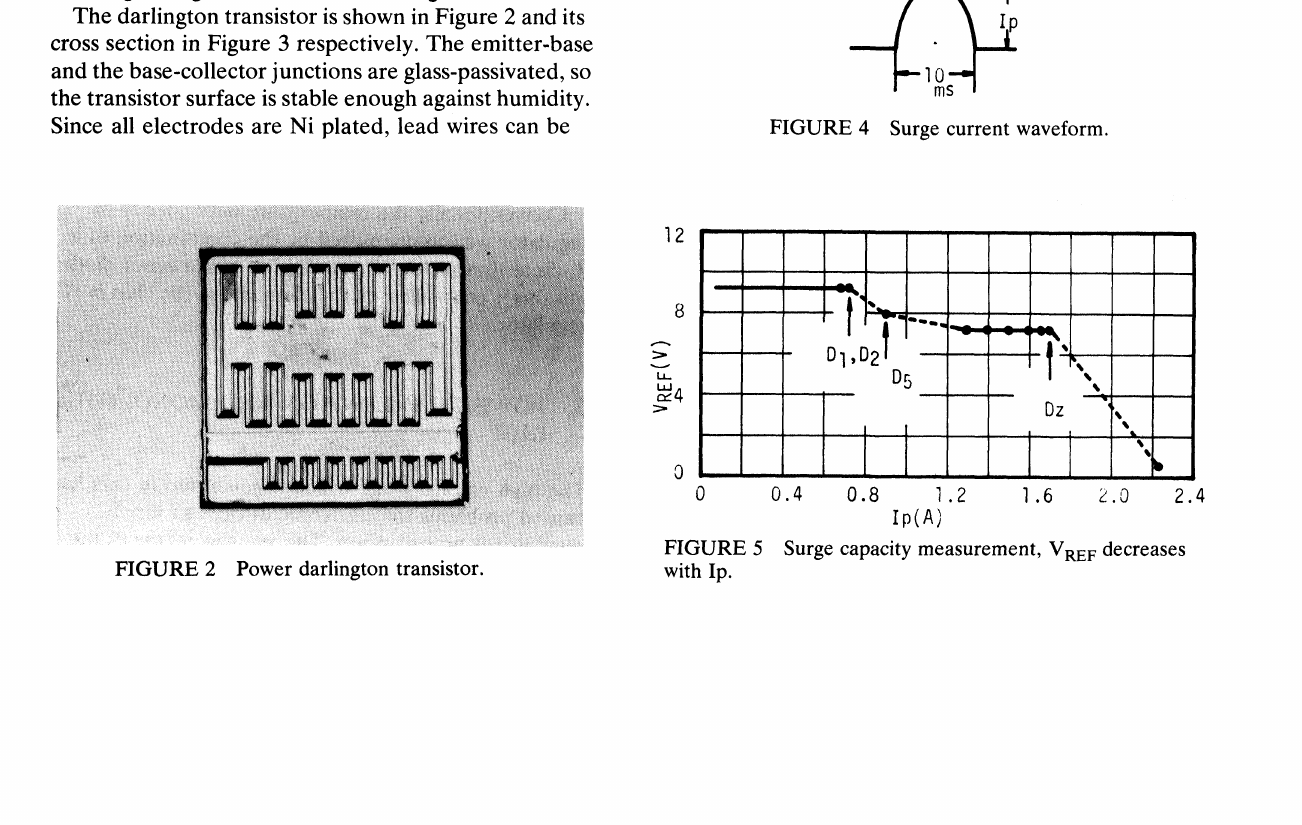
FIGURE 2 Power darlington transistor.